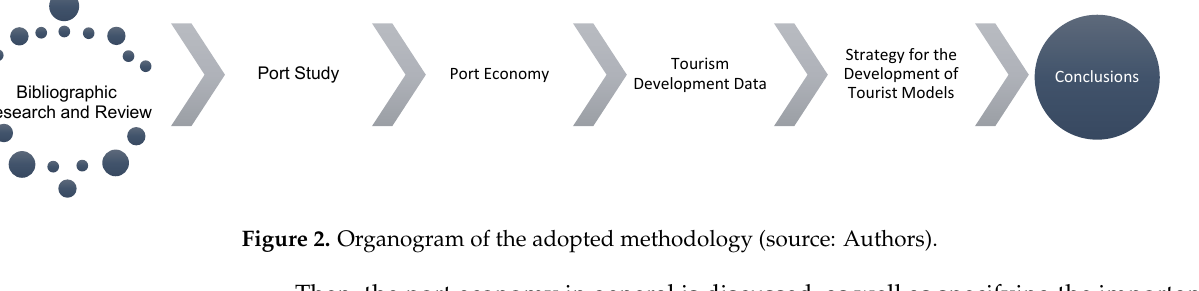
Figure 1. Archipelago of Madeira—Porto Santo Island. (Source: Authors by ESRI ArcGIS, 2020).